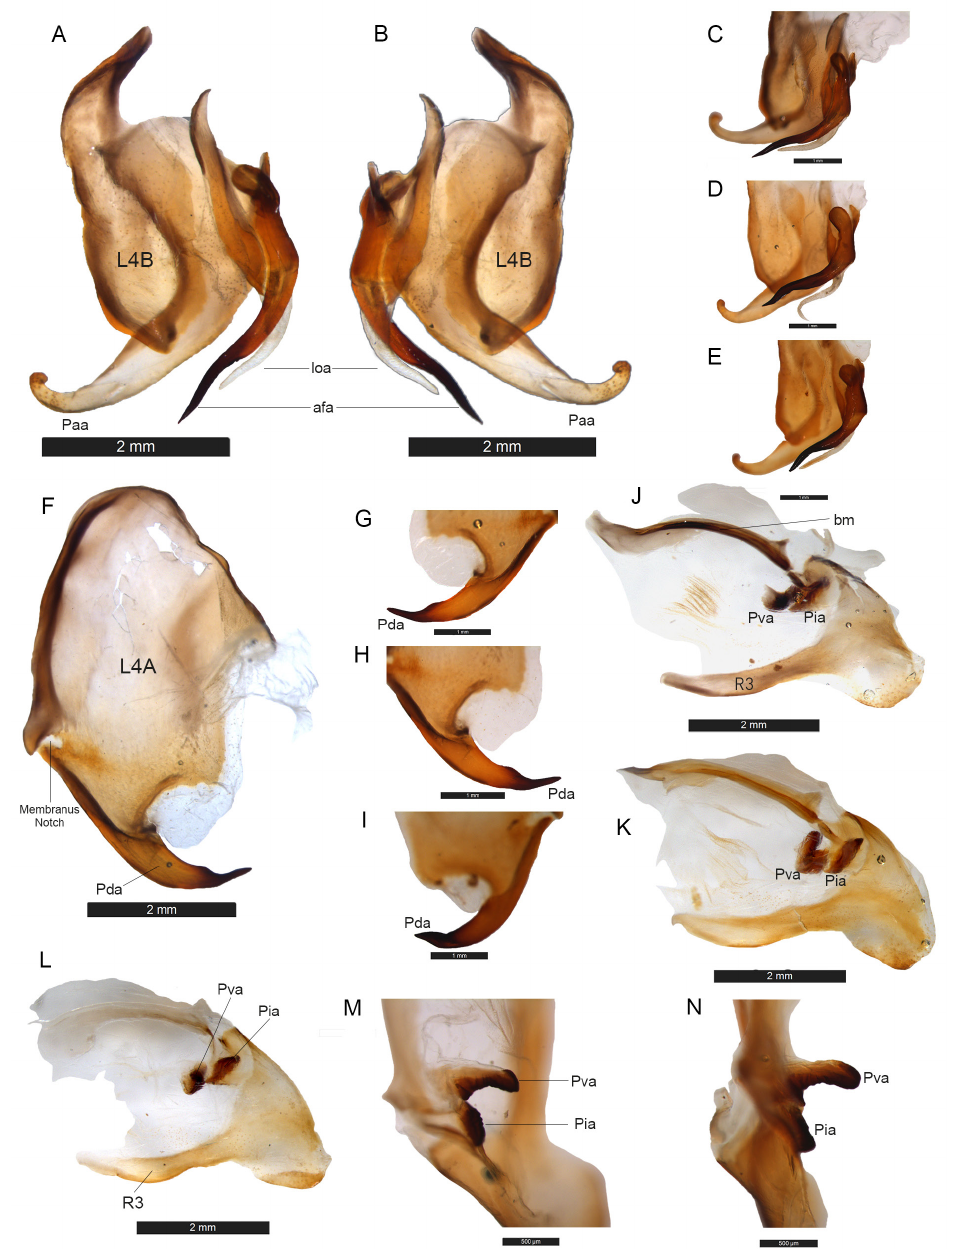
Fig. 5. Male genital structures of Vates phoenix sp. nov., highlighting variation across